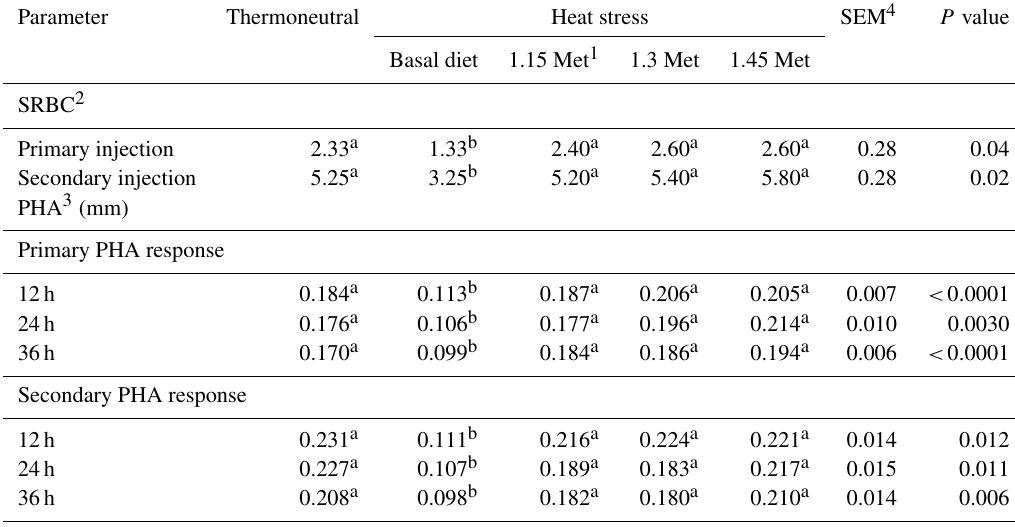
Table 6. Effect of methionine on humoral (log 2 ) and cell immune response in breeder quails. Parameter